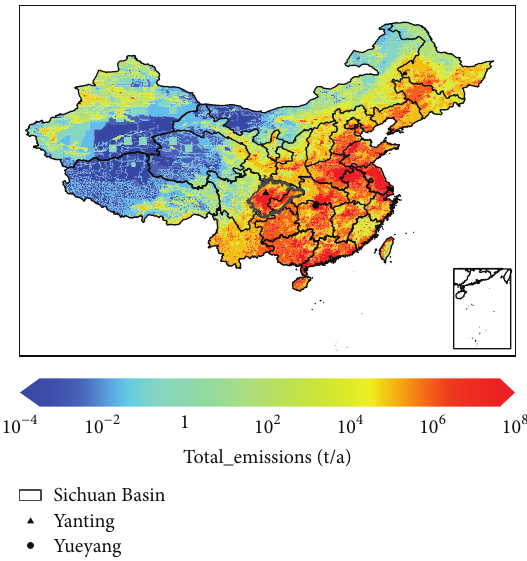
Figure 2: Amount of CH 4 emissions in China region in 2010 from EGDAR 4.2 data (colorbar of the emission value are shown by taking their base 10 logarithms).